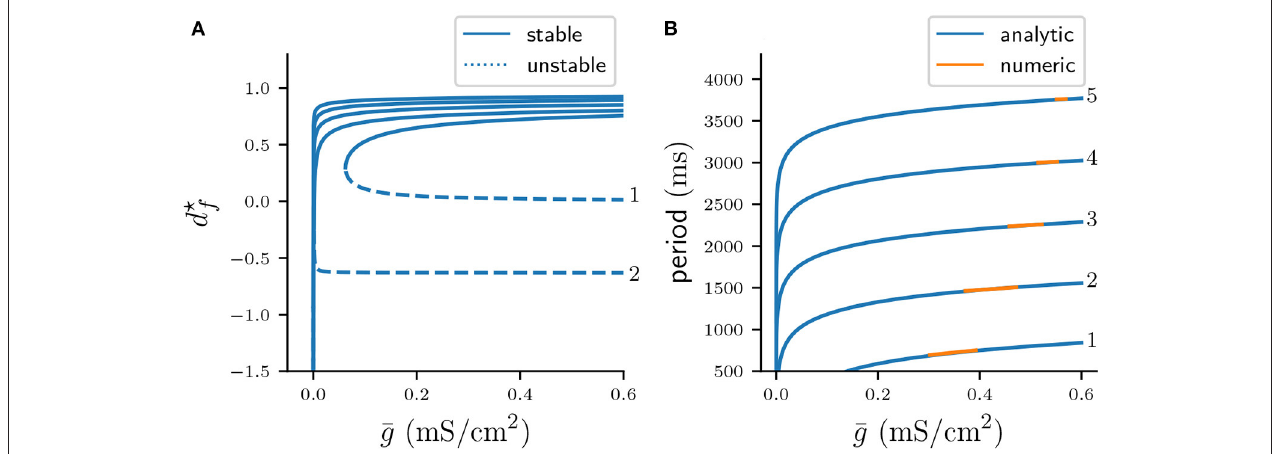
FIGURE 9 | (A) Fold bifurcation diagrams of stable (continuous curves) and unstable (dotted curves) fixed points of 5 n for varying n . (B) Cycle periods computed from stable fixed points of 5 n (blue), and the corresponding periods from stable n : n solutions acquired via numerical integration of the system of ODEs